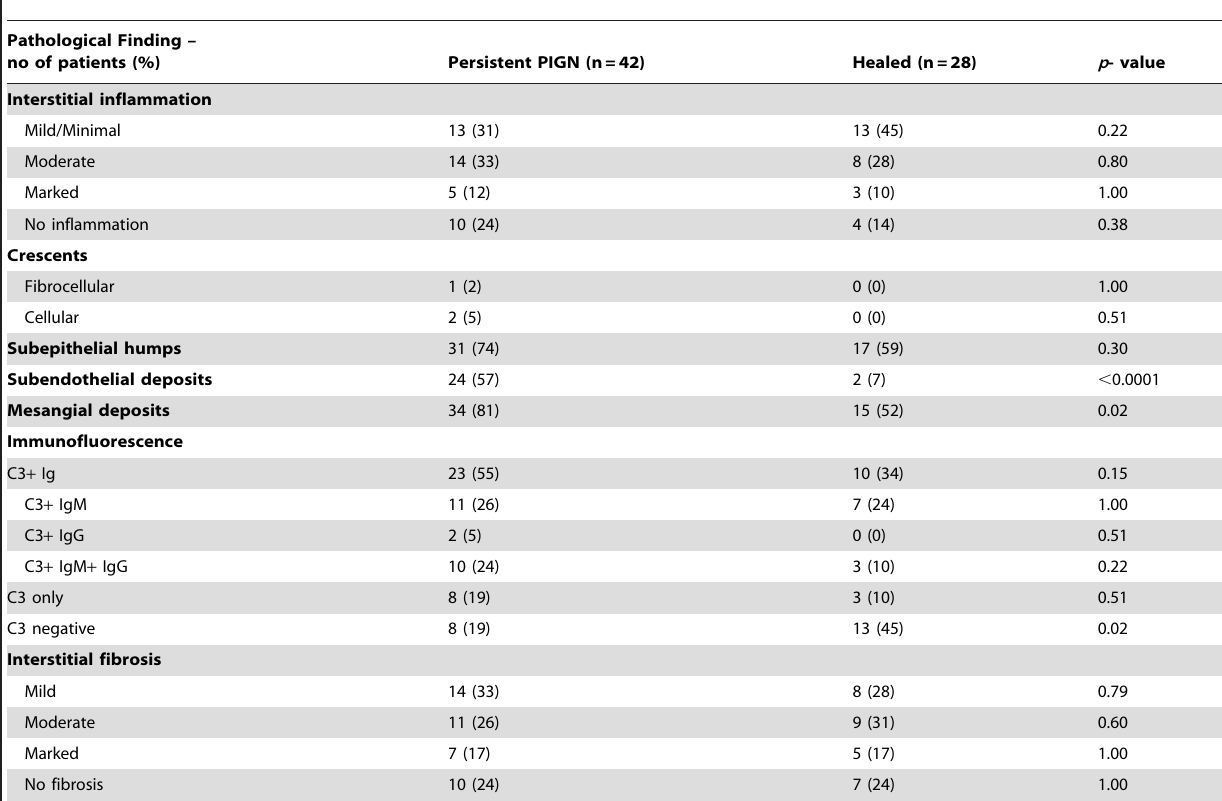
Table 3. Summary of pathological findings on 70 patients with persistent and healed PIGN.